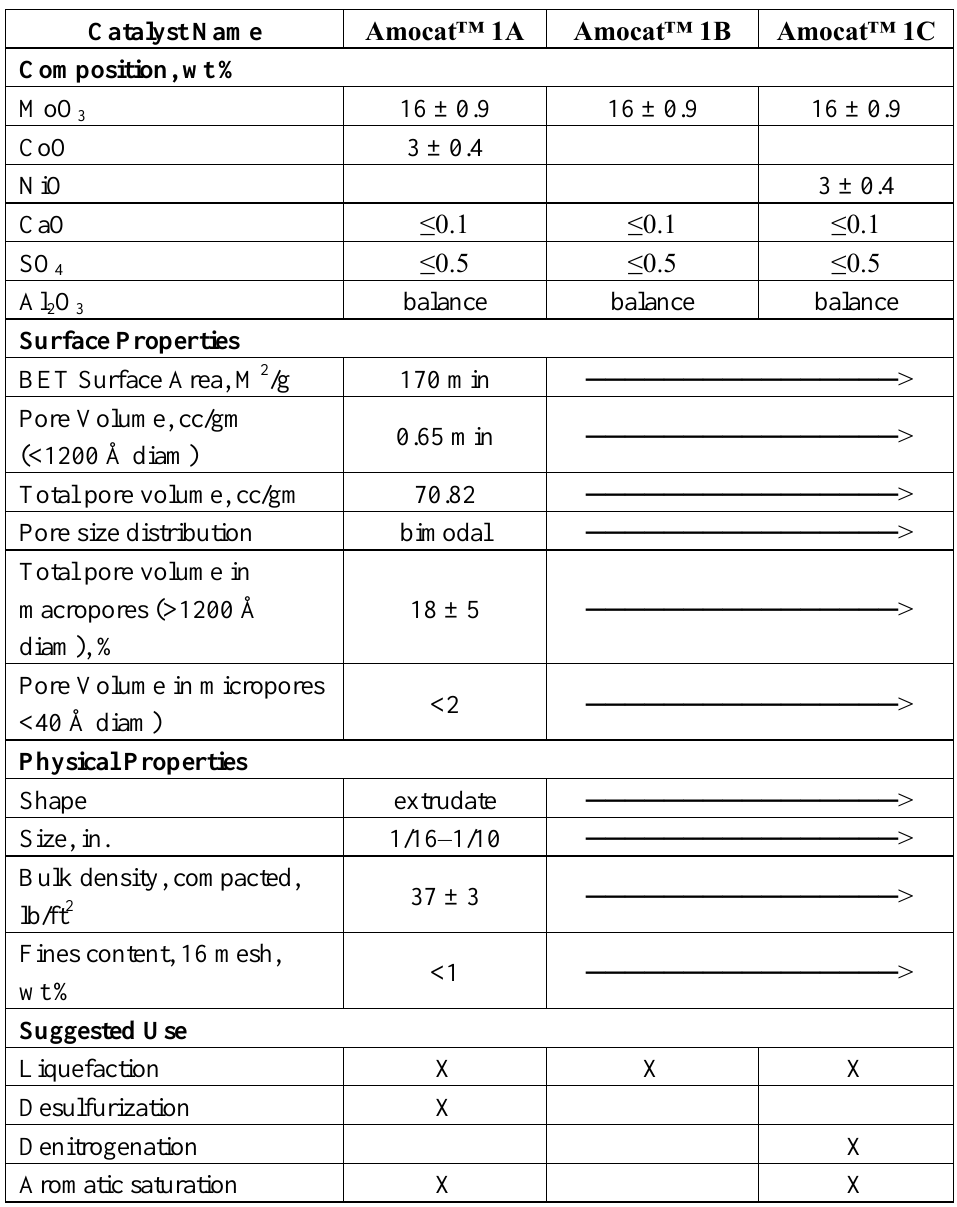
Table 6. Catalysts used in pilot plant